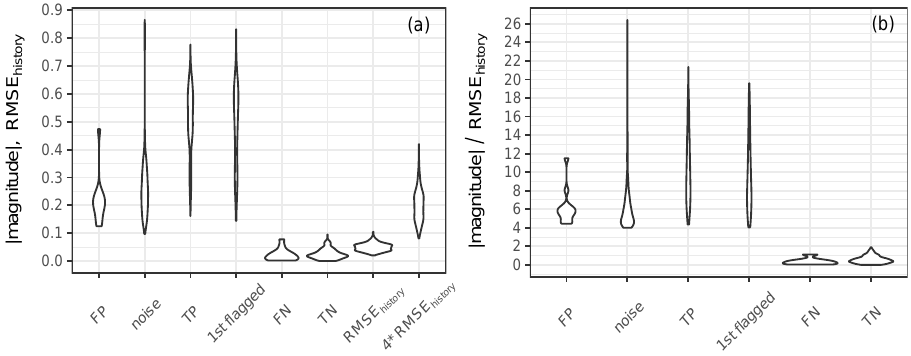
Figure 10. Distribution of ( a ) spectral change magnitude, and ( b ) spectral change magnitude as a factor of history model RMSE ( RMSE history ) associated with commission error (false positive, FP), noise (i.e., the residual of observations flagged as anomaly but did not lead to a confirmed deforestation event), true positive (TP), “1st flagged” (i.e., the residual of first-time anomaly which led to confirm the deforestation), omission error (FN), and true negative (TN) in deforestation detection by the proposed algorithm with optimal (i.e., highest spatial accuracy) cons = 3 and k = 4. In FP and TP cases, the magnitude is calculated as the median of consecutive anomalous observations which led to a confirmed deforestation. In FN and TN cases (deforestation not detected), the magnitude is calculated as the median of all observations in the monitoring